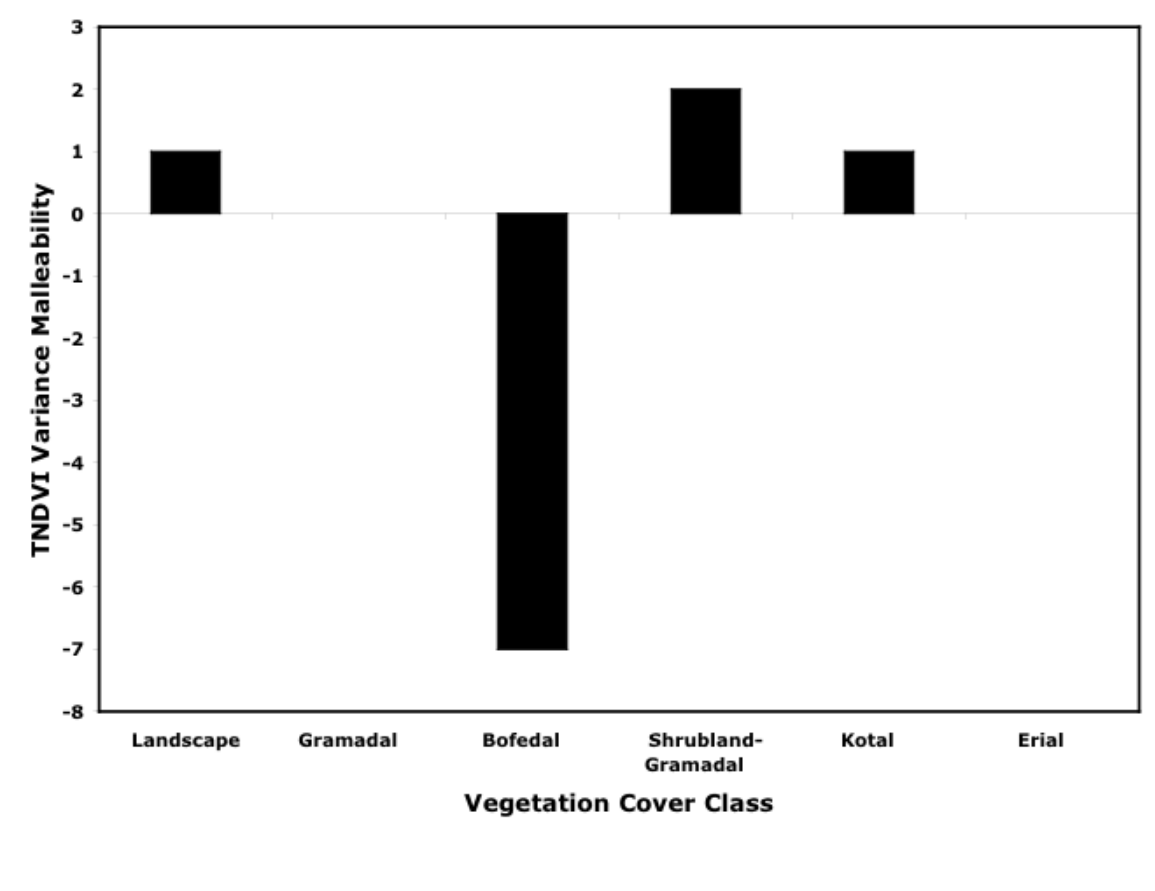
Fig. 5. Mean-variance portraits are quantified in terms of characteristics of ecological resilience, particularly by malleability, which is the degree of recovery toward initial conditions (in 1972) after a disturbance. Malleability is calculated by subtracting the mean of the transformed normalized difference index (TNDVI) variance for 1986 and 1987 from the mean of the TNDVI variances for 1984, the disturbance (drought)